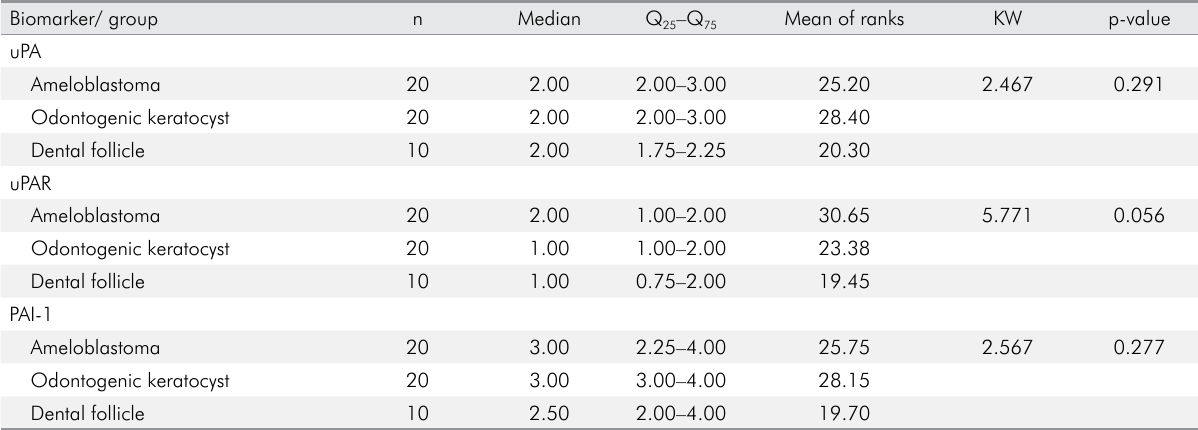
Table 5. Parameters used for the calculation of the Kruskal-Wallis (KW) test for the evaluation of the scores of connective tissue immunoexpression of uPA, uPAR, and PAI-1 in ameloblastomas, odontogenic keratocysts, and dental follicles.